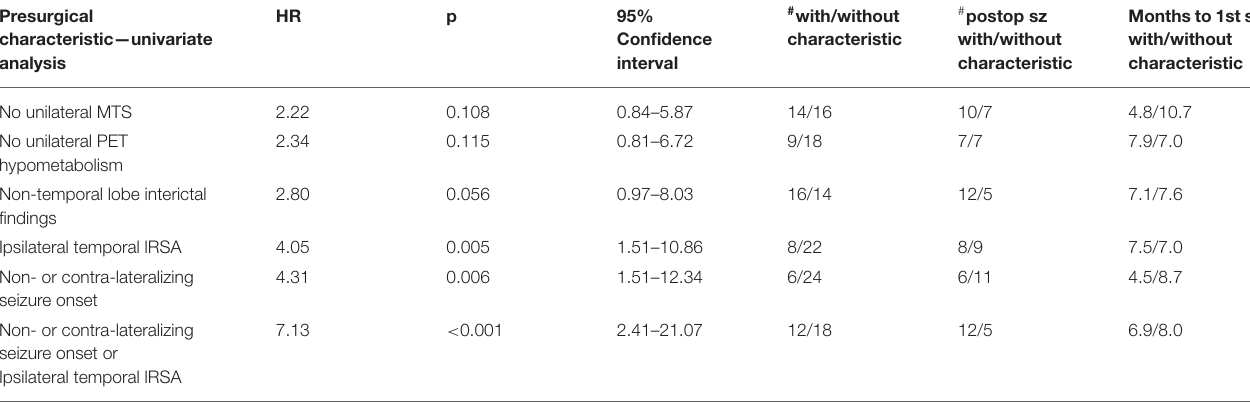
TABLE 2 | Hazard ratios associated with characteristics identified during presurgical planning.